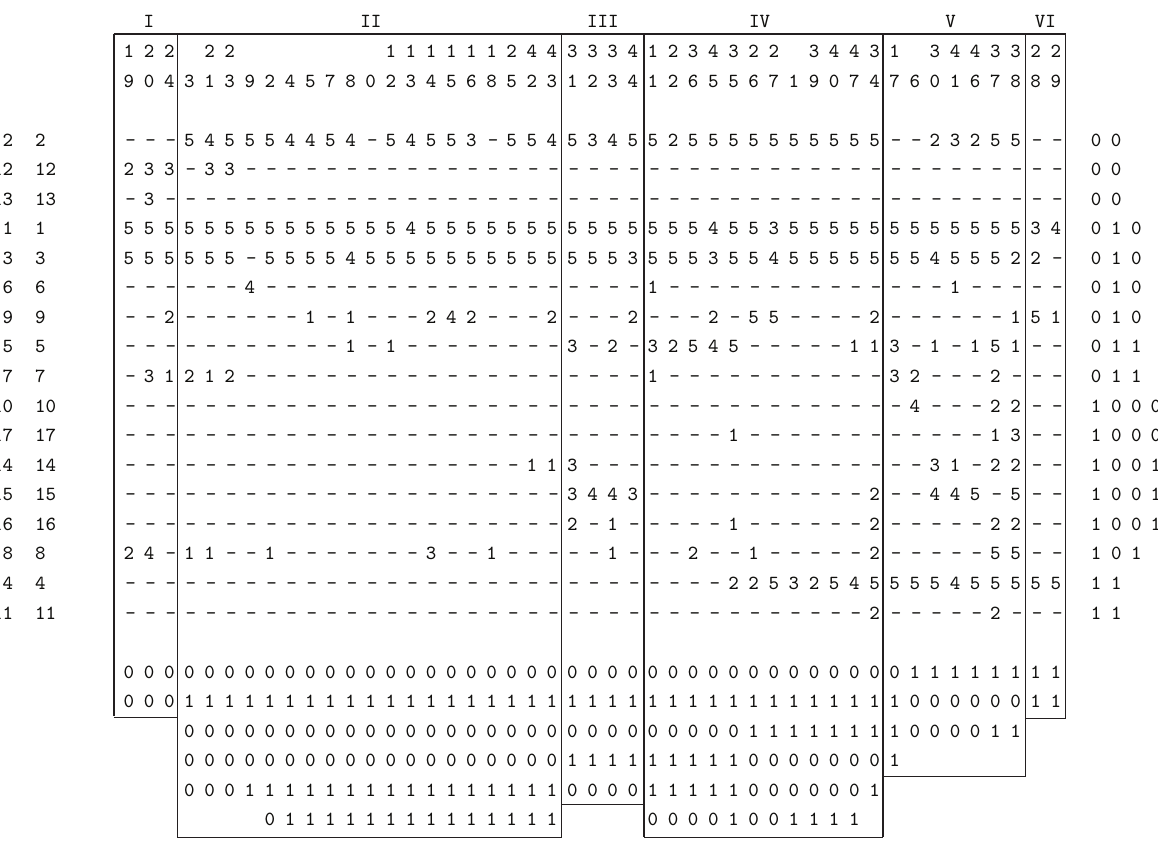
Figure 5: TWINSPAN analyses. Note: 1-Carex lasiocarpa, 2-Glyceria spiculosa, 3-Carex pseudo-curaica, 4-Calamagrostis angustifolia, 5- Galium manshuricum Kitag., 6-Galium dahuricum Turcz, 7-Comarum palustre L., 8-Equisetum fluviatile, 9-Carex humida, 10-Phragmites australis, 11-Anemone dichotoma, L. 12-Menyanthes trifoliate, 13-Achillea acuminate, 14-Lathyrus quinquenervius., 15-Carex dispalata, 16-Salix rosmarinifolia, L. 17-Caltha palustris var, sibirica.